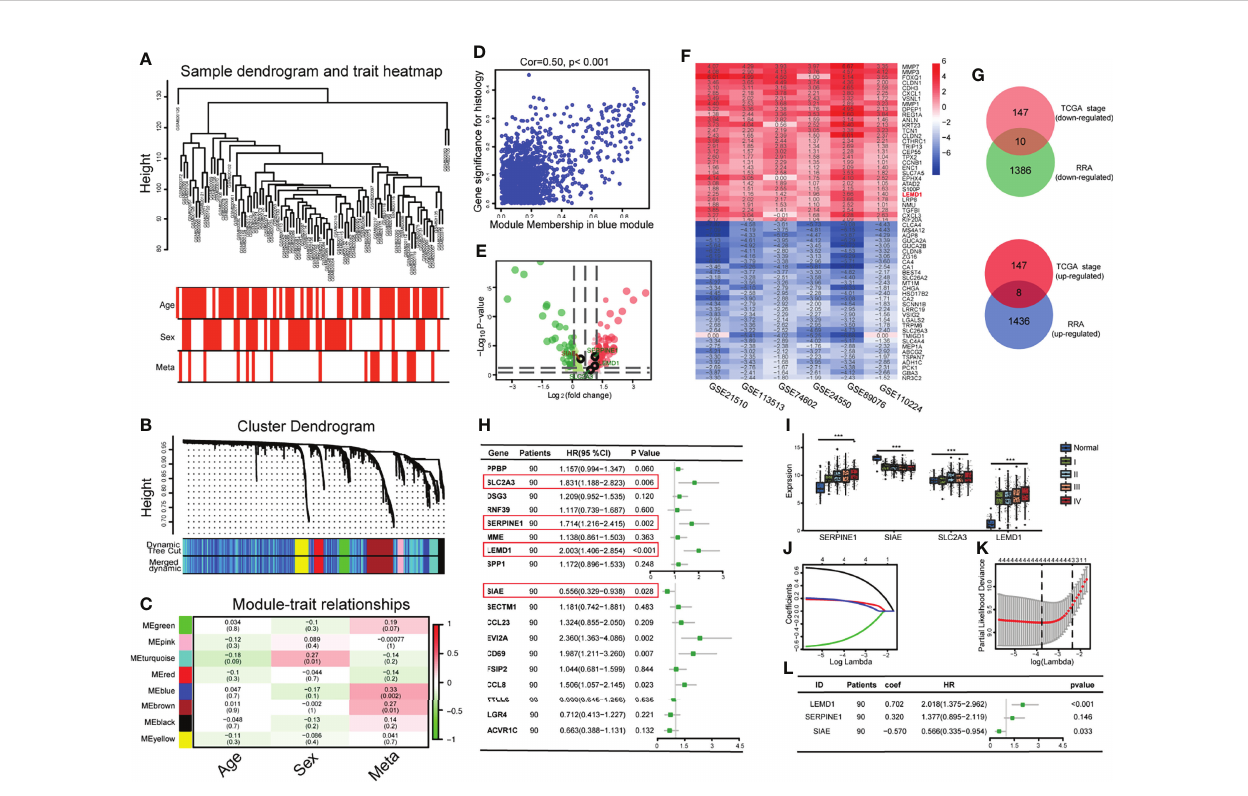
FIGURE 2 | Development of an early relapse model: (A) Establishment of a weighted co-expression network and identi fi cation of core modules; (B) Gene clustering and identi fi cation of gene modules; (C) Correlation between gene modules and clinical data; (D) A scatterplot of Gene Signi fi cance (GS) vs. Module Membership (MM) in the blue module.; (E) Volcano map of differentially expressed genes between stages I/II and III/IV. Green dots indicate lowly expressed genes in stage III/IV. Red dots indicate highly expressed genes. (F) Heat map of the 30 most robust differentially expressed genes in the 6 CRC datasets analyzed by RRA analysis; (G) 18 Hub genes were obtained through the intersection of the genes selected by the RRA method and the WGCNA method; (H) Hub genes were subjected to univariate regression analysis and forest plots were drawn; (I) The expression of SLC2A3, SERPINE1, LEMD1, and SIAE are related to the TNM stage; (J, K) The Lasso regression model analysis was designed to exclude highly correlated (co-expressed) genes and to prevent the model from over fi tting; (L) Multivariate regression analysis Forest Map consisting of SERPINE1, LEMD1, and SIAE. ***P <